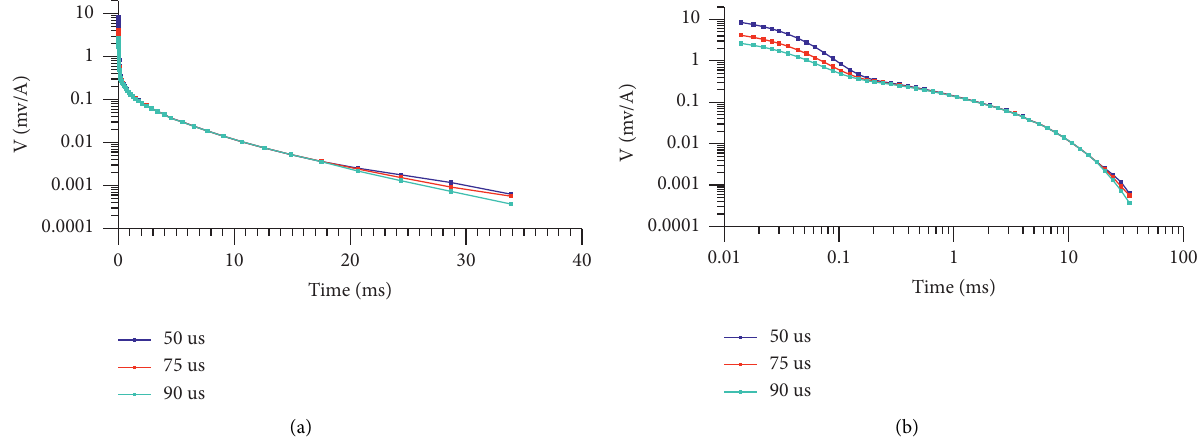
Figure 5: Comparison of V(t)/I attenuation curves with turn-off time of 50us, 75us, and 90us. (a) 0–40ms. (b) 0.01–100